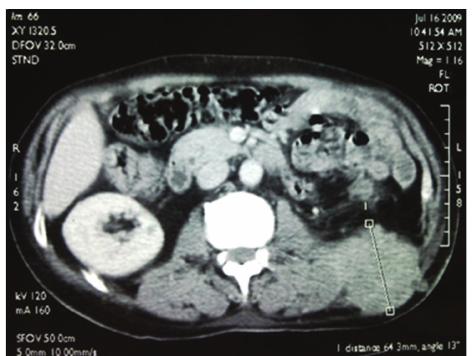
Figure 2: Left lumbar mass invading the iliopsoas muscle.